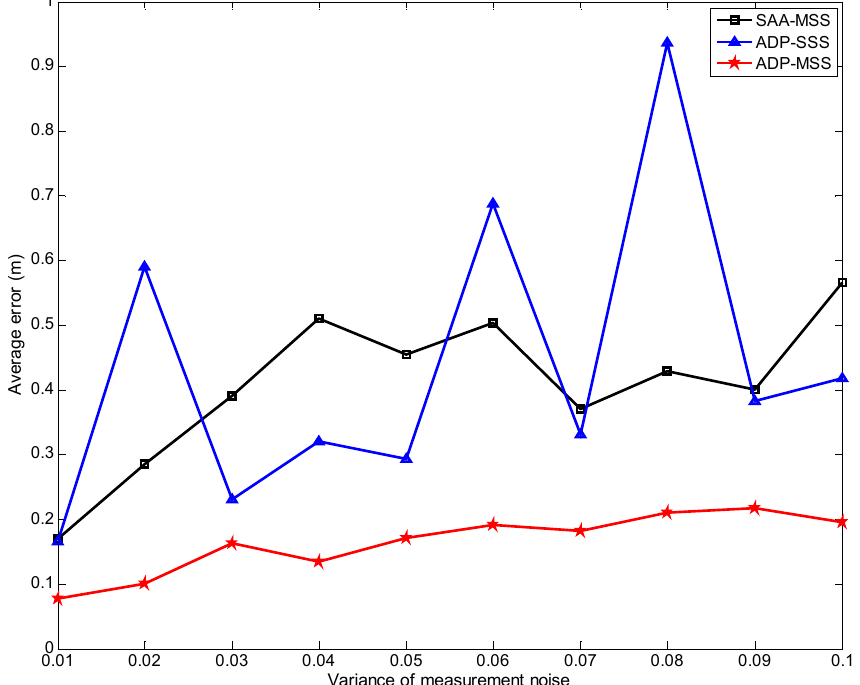
Figure 8. The average tracking error when the variance of the measurement noise changed from 0.01 to 0.1.